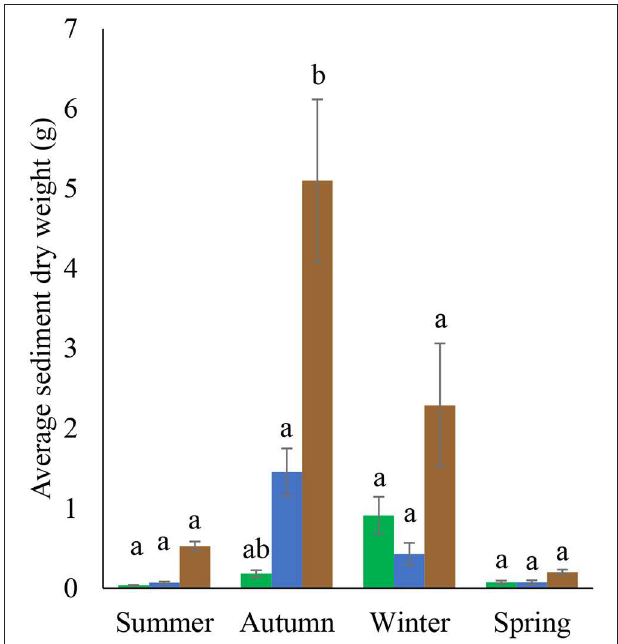
FIGURE 6 | Averaged sediment deposition (dry weight in grams) quantities measured in each area during each season. The average in each area was calculated from samples collected at four points on four occasions ( n = 16 per area). Letters show significant differences between sediment deposition across each area and season. Colors represent natural area (green), restored area (blue), and the mudflat (brown).